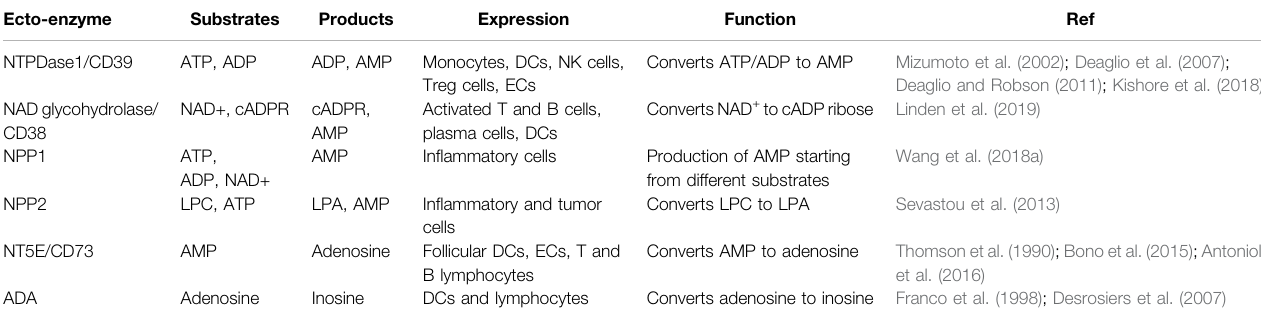
TABLE 1 | Main ectonucleotidases and ecto-enzymes involved in regulation of purinergic signalling. Ecto-enzyme